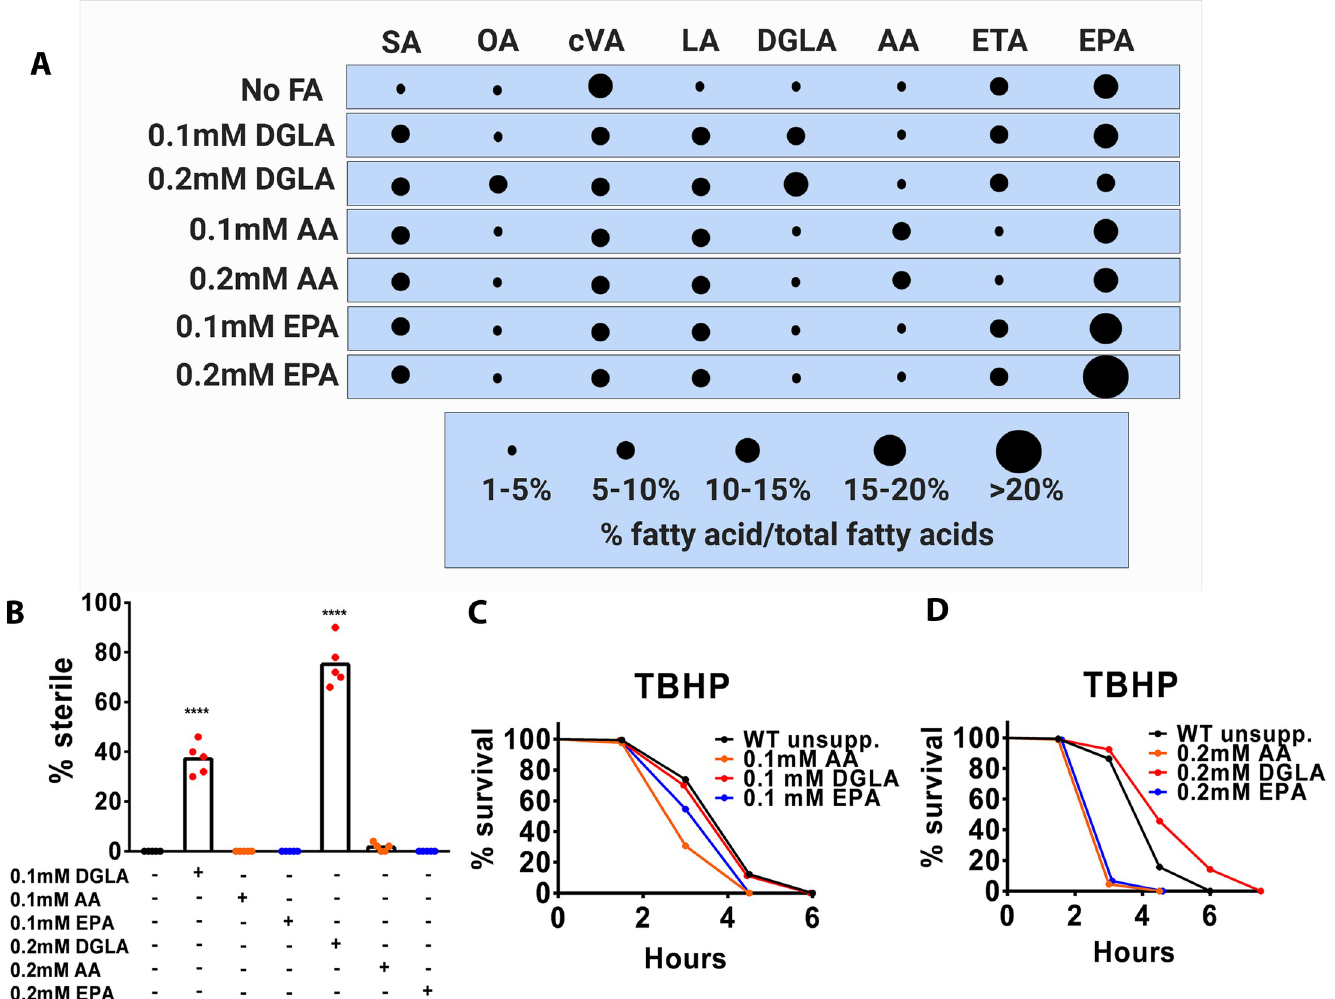
Fig 3. Exogenous 20-carbon PUFAs differentially modulates ferroptosis and peroxide-induced oxidative stress. (A) Relative fatty acid composition in wild type worms treated with DGLA, AA, and EPA determined using gas chromatography-mass spectrometry. SA-stearic acid (18:0), Pla-plasmalogen, OA-oleic acid (18:1(n- 9)), cVA-cis-vaccenic acid (18:1(n-7)), LA-linoleic acid (18:2(n-6)), ALA-alpha linolenic acid (18:3(n-3)), GLA-gamma linolenic acid (18:3(n-6)), STA-stearidonic acid (18:(4n-3)), DGLA-dihomo-gamma linolenic acid (20:(3n-6)), AA-arachidonic acid (20:(4n-6)), ETA-eicosatetraenoeic acid (20:(4n-3)), EPA-eicosapentaenoic acid (20:(5n-3)) (B) Percentage (%) sterility of wild type wormsraised on the indicated fatty acids. (C and D) Survival of young adult worms raised on the indicated fatty acids before exposure to 14.7mM tert-butyl hydroperoxide (TBHP). In (B) each dot represents an independent experiment of 50 worms for each treatment. Statistical significance was determined using a two-way ANOVA with Tukey’s test for multiple comparisons summarized in S2 Table. In (C and D) approximately 100–200 worms were used for each strain per treatment. Statistical significance for survival was determined using log rank tests (Mantel Cox) is shown in S2 Table. In (B, C and D), fatty acid compositions are reported in S1